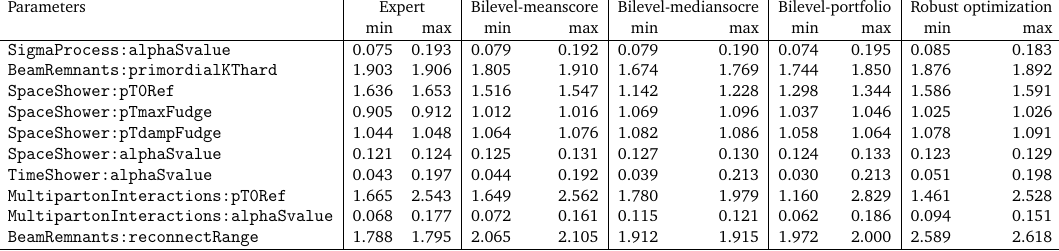
Table 13: Eigentune results for the A14 data using the rational approximation for different optimization